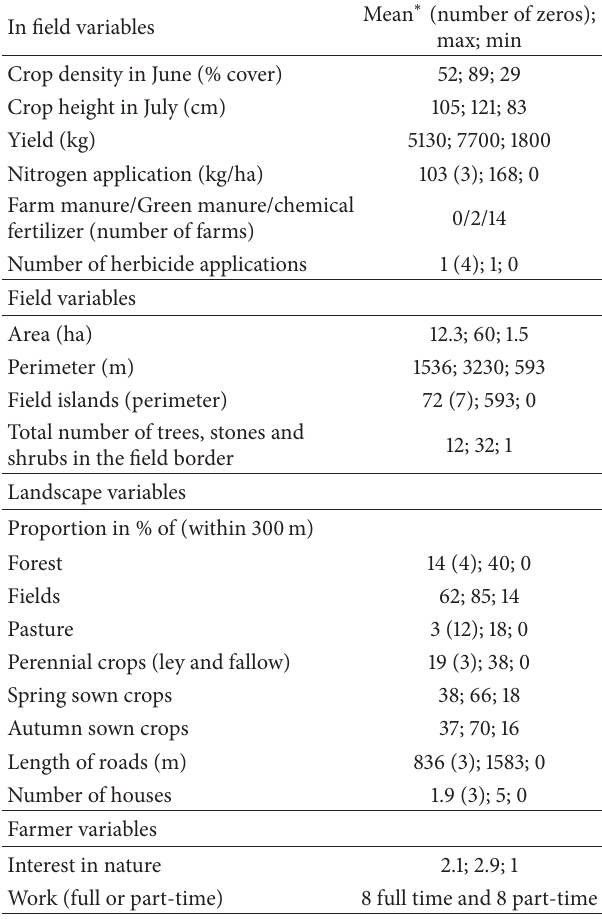
Table 2: All measured landscape, field and farmer variables pre- sented with mean, max and min